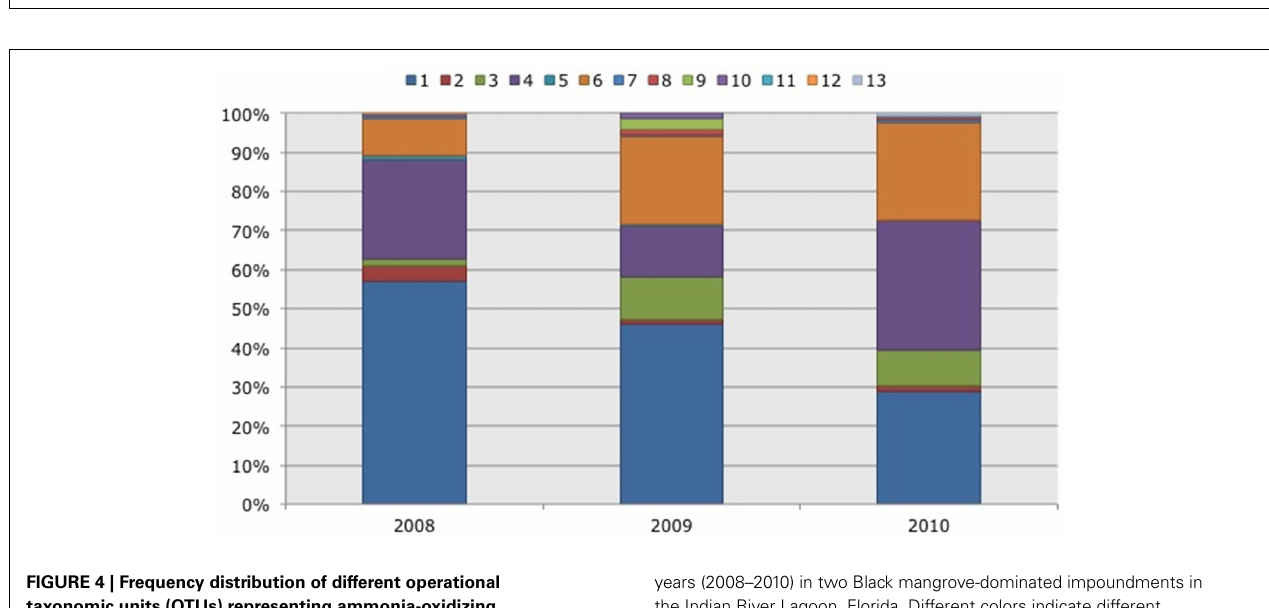
FIGURE 3 | Frequency distribution of different operational taxonomic units (OTUs) representing ammonia-oxidizing betaproteobacteria. Soil samples had been taken in a non-flooded (number 23) and a